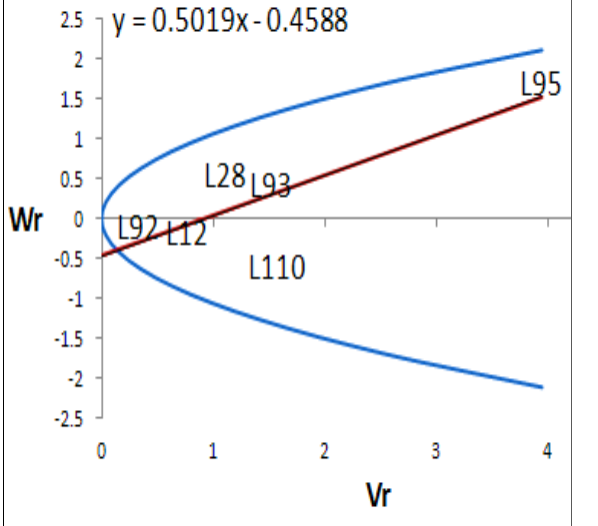
Fig. 5b: Wr/Vr graphs for number of branches per plant under WSC